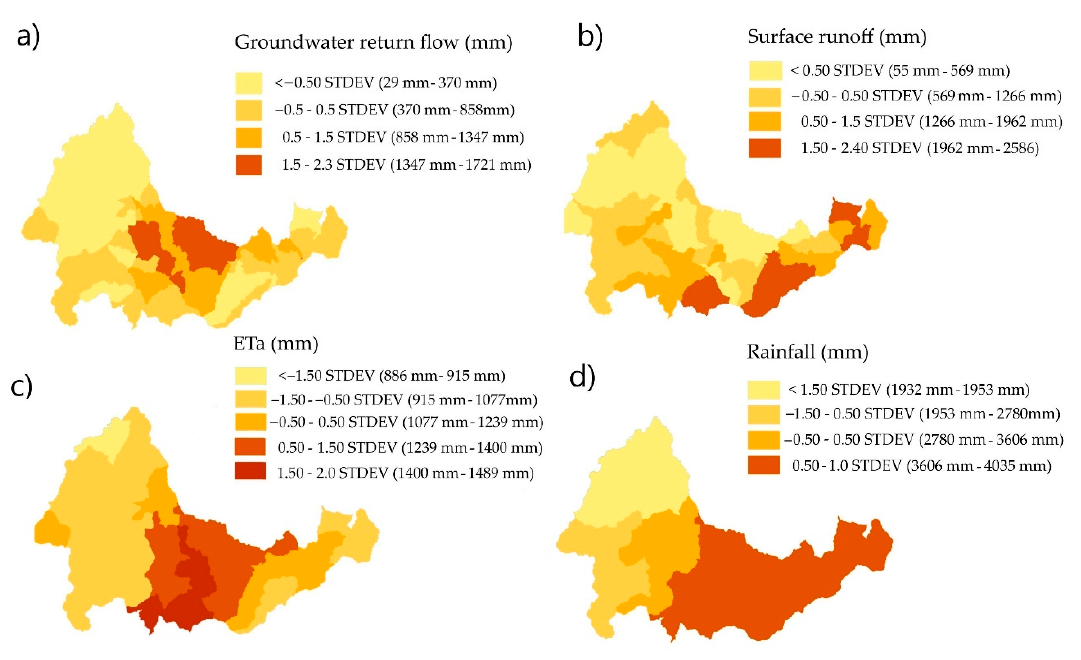
Figure 8. Spatial average annual amount of ( a ) groundwater return flow, ( b ) surface runoff, ( c ) ET a , and ( d ) rainfall with respect to the standard deviation (STDEV).